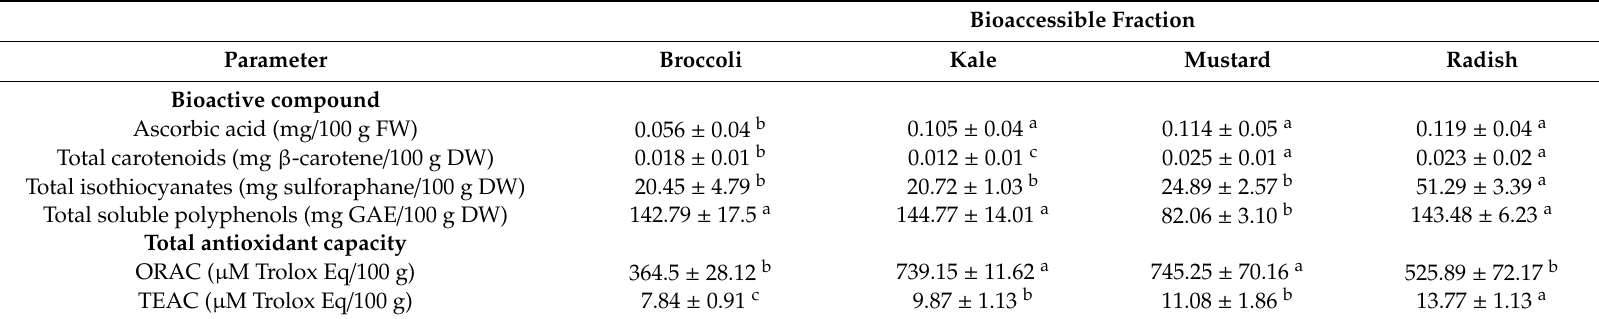
Table 1. Concentration of antioxidant bioactive compounds and total antioxidant capacity present in the bioaccessible fractions of microgreens used for antiproliferative e ff ect in Caco-2 cells (diluted 1:10 v / v in Dulbecco’s Modified Eagle Medium (D-MEM)), calculated from previous data